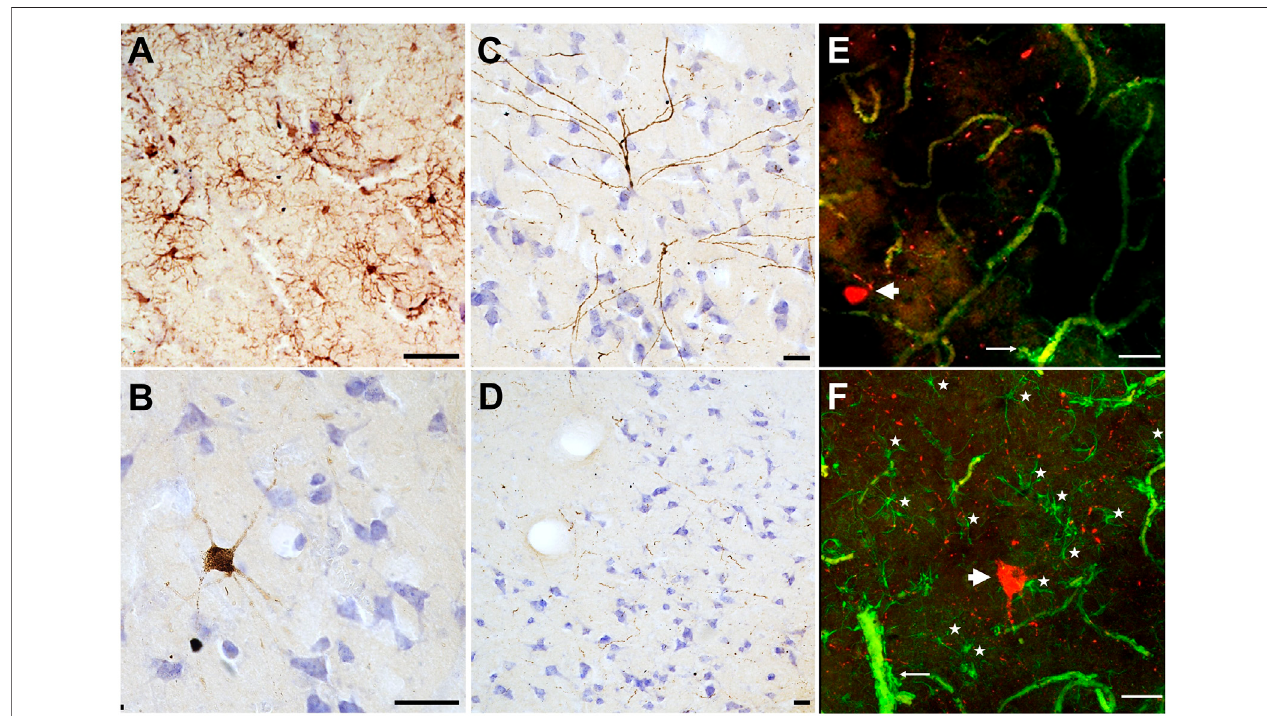
FIGURE 1 | Microglia and phospho-tau detected in brain tissue collected from the cortex of a 51-year-old female Asian zoo elephant ( Elephas maximus ). Tissue stainedusingimmunohistochemistryandcounterstainedwithcresylviolet, (A) IBA1(brown,1:1,000,Fuji fi lm,019 – 19,741), (B – D) CP13(brown,1:1,000,GiftfromDr.P. Davies). Images (A – D) were taken on an Axiophot bright fi eld microscope (Carl Zeiss Microscopy, Jena, Germany), with a 10x/0.32 Plan-Apochromat objective. (E – F) Tissue was stained with CP13 (red) and GFAP (green, 1:1,000, Abcam., ab68428) using immuno fl uorescence (note that blood vessels appear in green due to auto fl uorescence). Images (E – F) were taken on a CLSM 780 confocal microscope (Carl Zeiss Microscopy, Jena, Germany), using a 20x/0.8 DICII objective and DPSS 561 – 10 diode and Argon lasers at excitation wavelengths of 555 and 488 nm. Confocal stacks in layers II and III of the cerebral cortex were imaged at 512 × 512 pixel resolution with a z-step of 1 µm for a pinhole setting of 1 Airy unit. Images are presented as maximum intensity projections of the Z-stack, made using ZenBlue (version 3.3, Carl Zeiss Microscopy, Jena, Germany). All scale bars are 50 μ m. In (A) , microglia are evenly distributed and rami fi ed without any activated (ameboid) forms. In (B, C) , neurons stained with tau were found in layers III and II, respectively. In (D) tau “ speckling ” is visible in brown throughout layer III, and it is also visible in (E – F) in red. Images (E – F) showtau-positiveneurons (thickarrowheads), and fi brilsin red,and astrocytes in green (aswell asauto fl uorescent blood vessels which aremuch